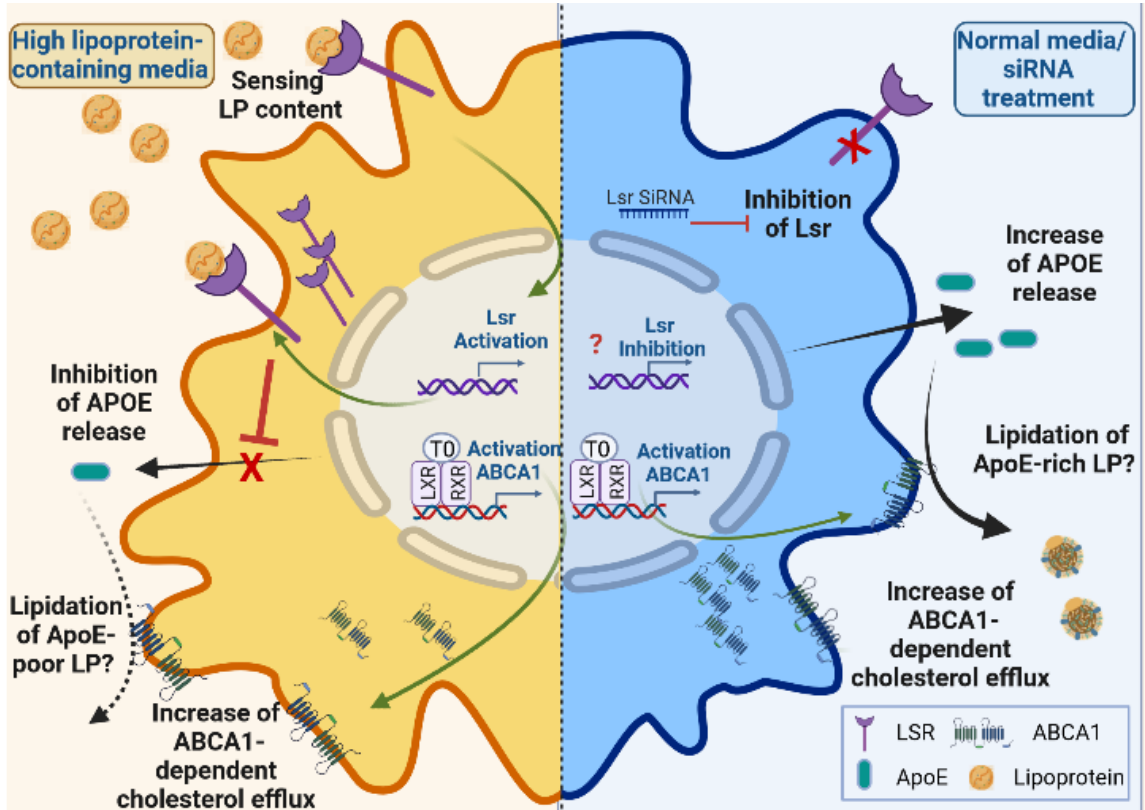
Figure 6. Working hypothesis of LSR effect on ApoE output in astrocytes. Our data show that high extracellular levels of lipoprotein (HM) stimulate lsr expression and decrease ApoE levels, suggesting a negative retro control of ApoE release from astrocytes, thus modulating ABCA1-mediated lipidation of lipoproteins. On the other hand, lsr reduction (siRNA) leads to release of lipidated ApoE and cholesterol into the medium. Transcriptional regulation of lsr by the LXR/RXR pathway depends on the lipoprotein content in the medium, while LXR upregulation of abca1 is not. We propose that the decoupling of cholesterol and ApoE release could influence the composition and lipidation of LP released by astrocytes. (LP = lipoprotein). Created with Biorender.com (accessed on 19 July 2022). Despite increased hmgcr expression, the cell cholesterol levels were actually lower following siRNA-mediated lsr knockdown (Figure 1). Together, this would suggest that lsr knockdown induced increased cholesterol efflux towards the extracellular media, providing additional insight in the decreased intracellular lipids observed following Nile red staining of brain sections from aged heterozygote lsr +/ − [18]. Although no difference in total choles- terol levels was detected in these mice, these analyses were based on total homogenates rather than specific cell types. Interestingly, the expression of cyp46a1 was increased as well, which may have contributed to the observed lower cell cholesterol levels. Cyp46A1